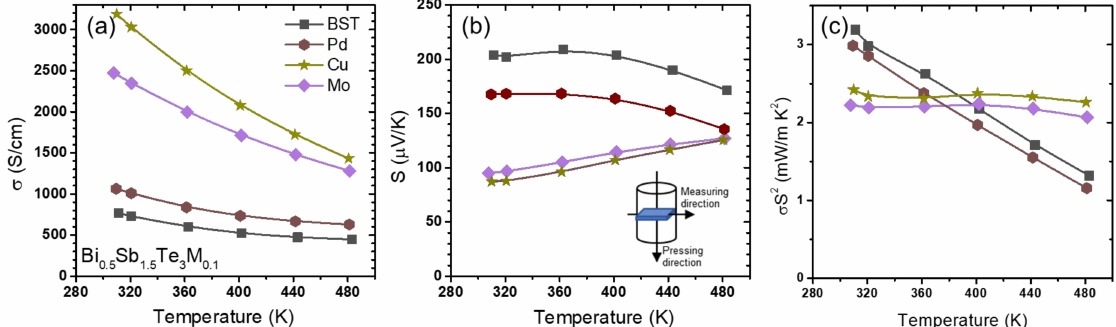
Figure 5. Temperature dependences of the ( a ) electrical conductivity, ( b ) Seebeck coefficient, and ( c ) power factor in Bi 0.5 Sb 1.5 Te 3 M 0.1 ( M = Ni, Pd and